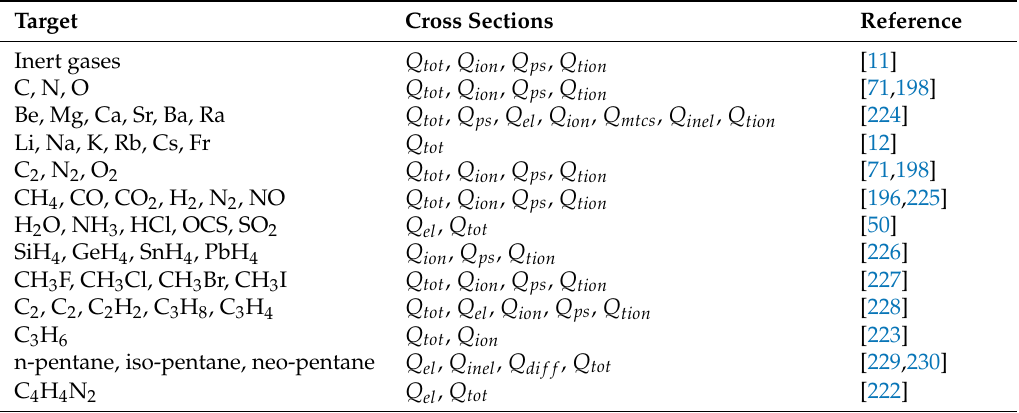
Table 2. Positron scattering cross section predicted through optical potential method with references ( Q tot : Total CS, Q ps : positronium formation CS, Q el : elastic CS, Q ion : direct ionization CS, Q mtcs : momentum transfer CS, Q inel : ine;elastic CS, Q tion : total ionization CS, Q dif f : differential CS). Target Cross Sections